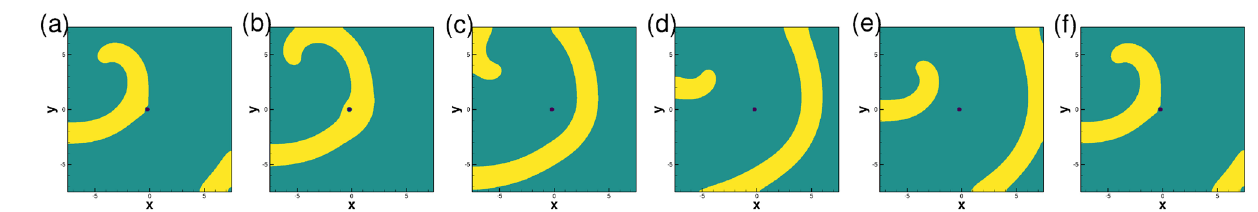
Figure 10. Evolution of periodic pattern under the effect of both ostacle and straining (γ = 0.005 ) : ( a ) t 0 , ( b ) t 0 + 1 ∗ T / 5 , ( c ) t 0 + 2 ∗ T / 5 , ( d ) t 0 + 3 ∗ T / 5 , ( e ) t 0 + 4 ∗ T / 5 , and ( f ) t 0 + 5 ∗ T / 5 . Here, T = 1.538